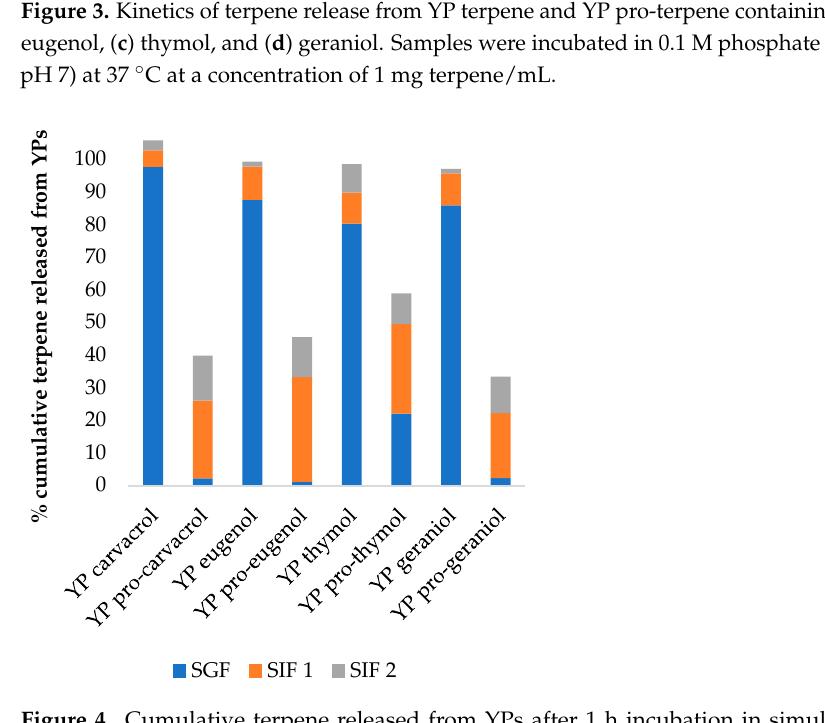
Figure 4. Cumulative terpene released from YPs after 1 h incubation in simulated gastric fluid (SGF) containing pepsin and after two 1 h incubations in fresh simulated intestinal fluid (SIF) with pancreatin.